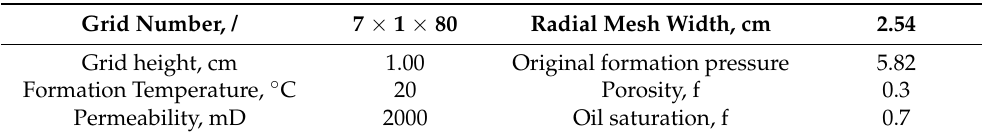
Table 3. The key parameters of the reservoir.